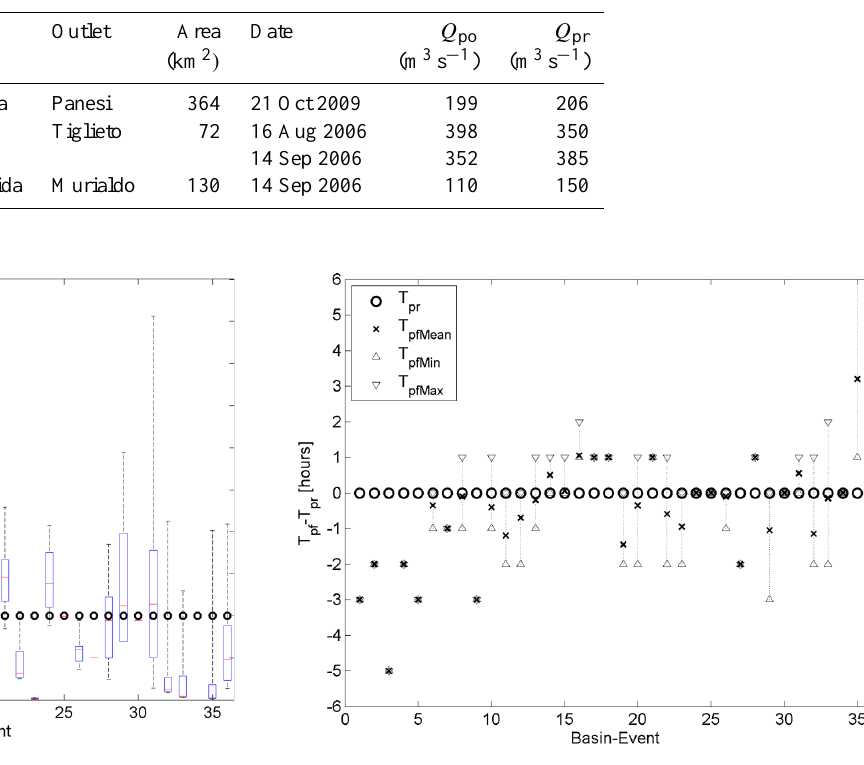
Fig. 8. Results of hydrological nowcasting framework for basins with area ≤ 150km 2 in terms of peak flow with box plot representa- tion. The black dots are the Q pr (peaks of reference hydrographs). The box plots’ whiskers indicate the maximum and minimum peak flows, the red line indicates the mean value and the box indicates the 25% and 75% quantiles.